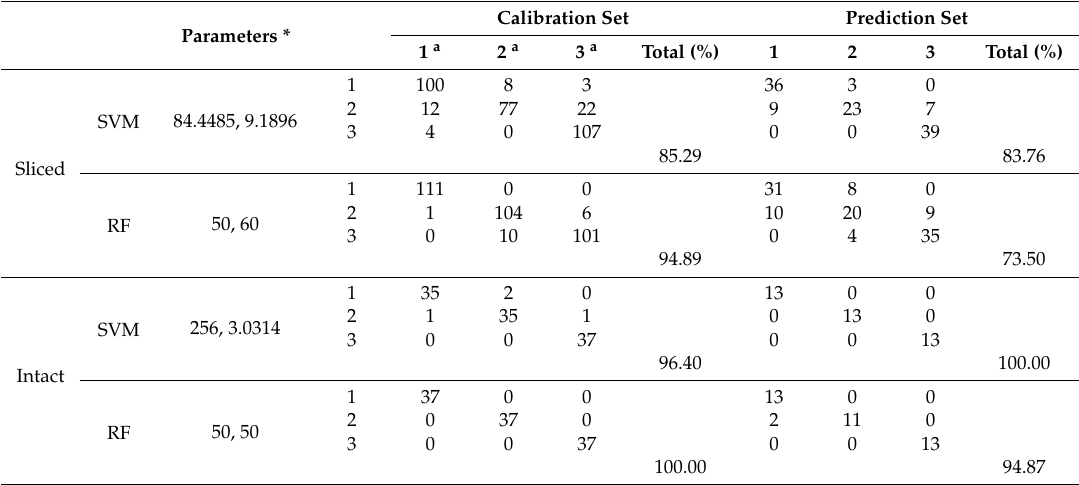
Table 1. Grading results of intact and sliced sausages by SVM and RF models. Calibration Set Prediction Parameters *